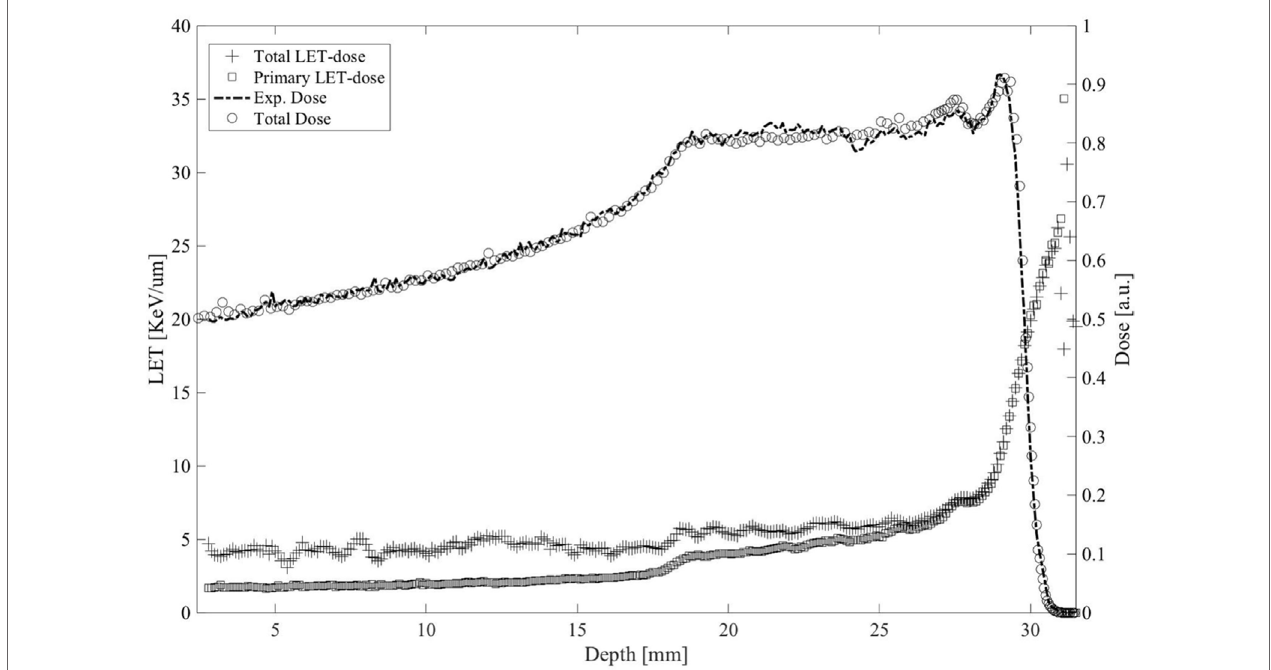
FIgURe 7 | Averaged LET-dose distributions calculated for only primary ion (square) and considering the contribute of the generated secondaries (cross) for a clinical spread-out Bragg proton peak calculated in water using the Hadrontherapy Geant4 simulation. Experimental and simulated SOBPs are also